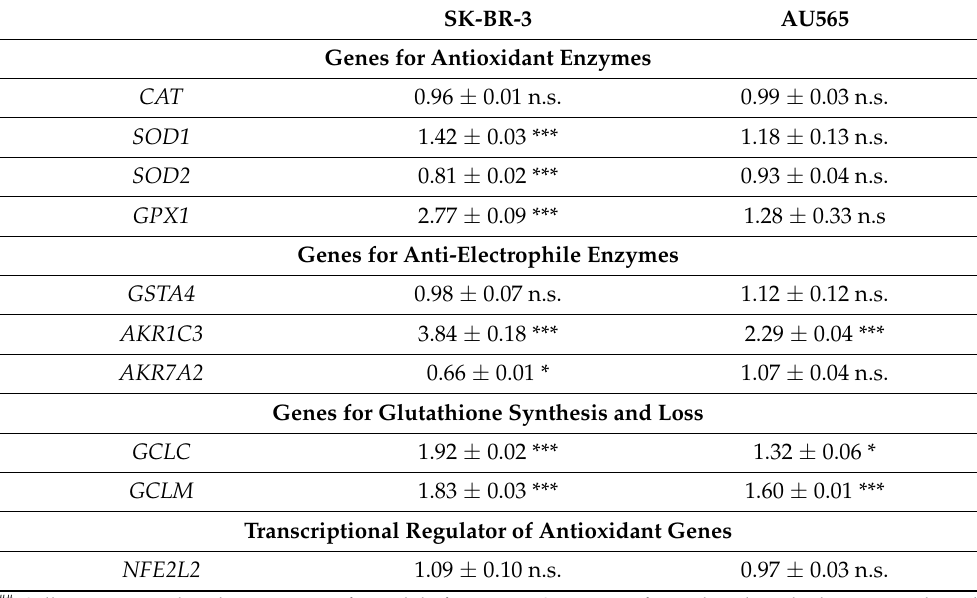
Table 2. Effect of AA on expression of antioxidant genes in SK-BR-3 and AU565 cells ## .